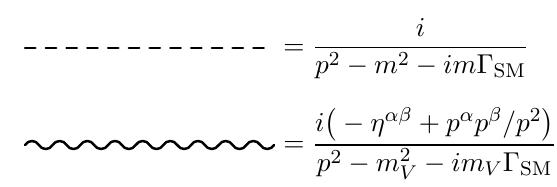
Figure 7. SM propagators for the Higgs and gauge